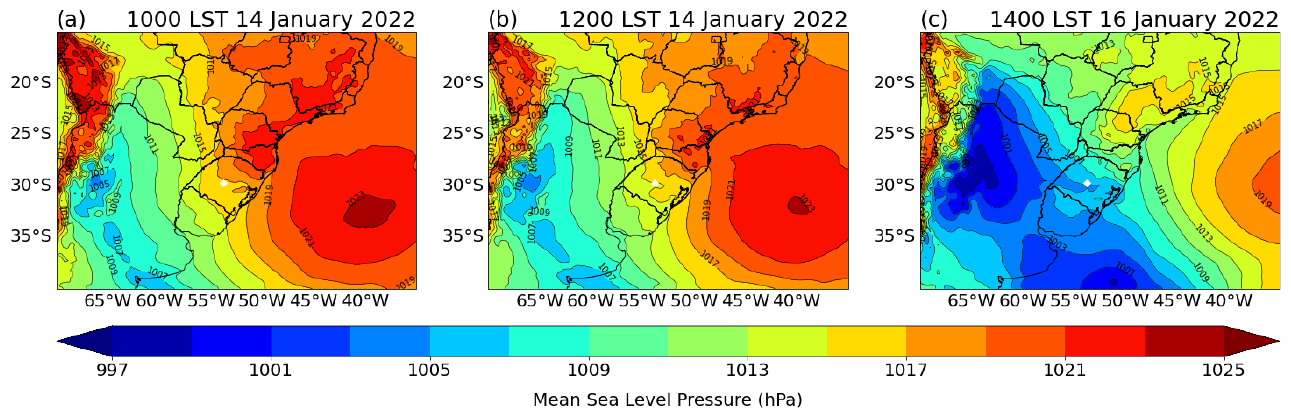
Figure 2. Maximum air temperature anomalies at 2 m and 10 m wind vectors for South America at: ( a ) 14 1000 LST; ( b ) 14 1200 LST; ( c ) 16 1400 LST; the white diamond indicates the location of the city of SM.